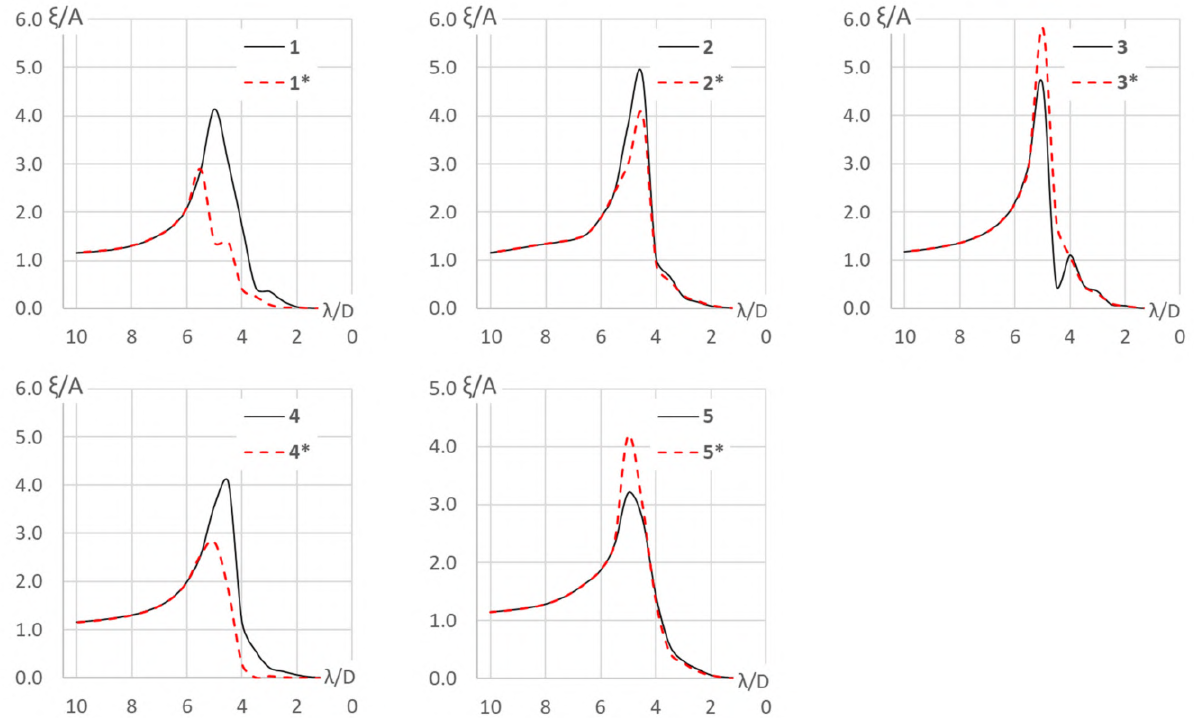
Figure 9. Heave motions with only wave radiation damping. “1–5” and “1*–5*” denote full wave field and local frequency truncated wave field at bodies 1 to 5, respectively. ξ denotes the heave motion amplitude and A stands for the local incoming undisturbed (full wave field) wave amplitude at each body.